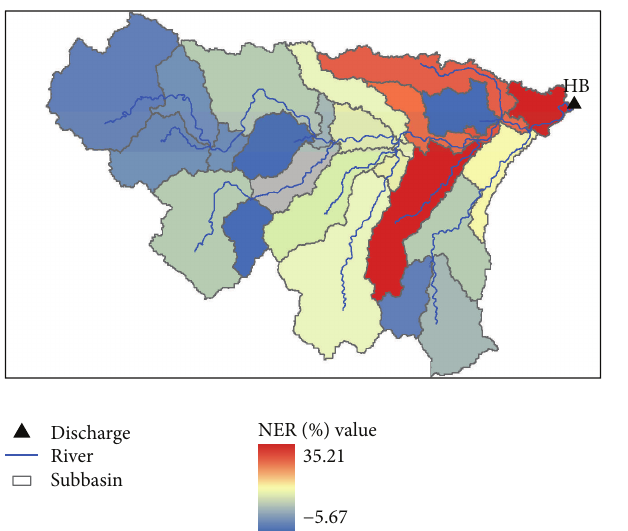
Figure 12: The correlation coefficients (CC) between the simulated streamflow at all subbasin outlets and that at the catchment outlet (HB station). The value of CC for one subbasin outlet is displayed on the subbasin where it is located. “Corr. Coef. versus HB” indicates the correlation coefficients between the streamflow at the subbasin outlet and that at HB